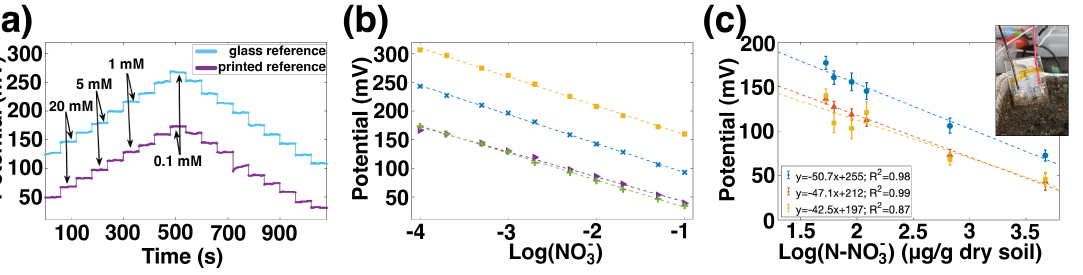
Figure 4. ( a ) Potential over time for an ISE measured against a commercial glass reference electrode (light blue) and against a printed reference electrode (dark purple). The change in reference electrode changed the E 0 of the pair by 87 mV. ( b ) Sensitivity curves for printed sensors from two different batches. The average sensitivity for these four sensors is 48.0 ± 3.3 mV/dec. ( c ) Potential versus nitrate concentration for three sensors in a high-organic-matter